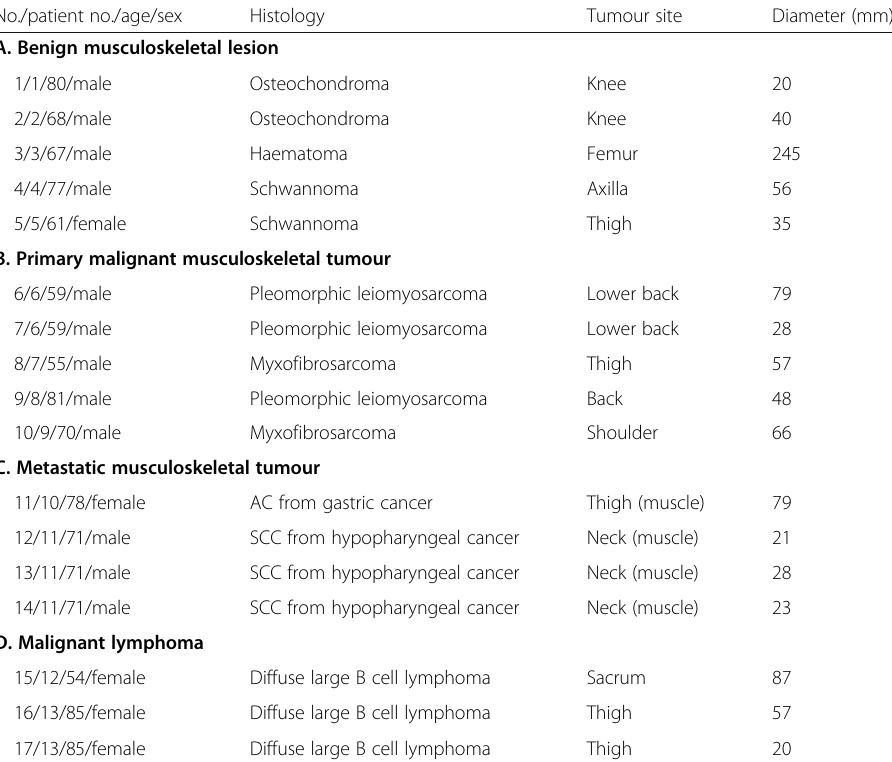
Table 1 Characteristics of patients and tumours No./patient no./age/sex Histology Tumour